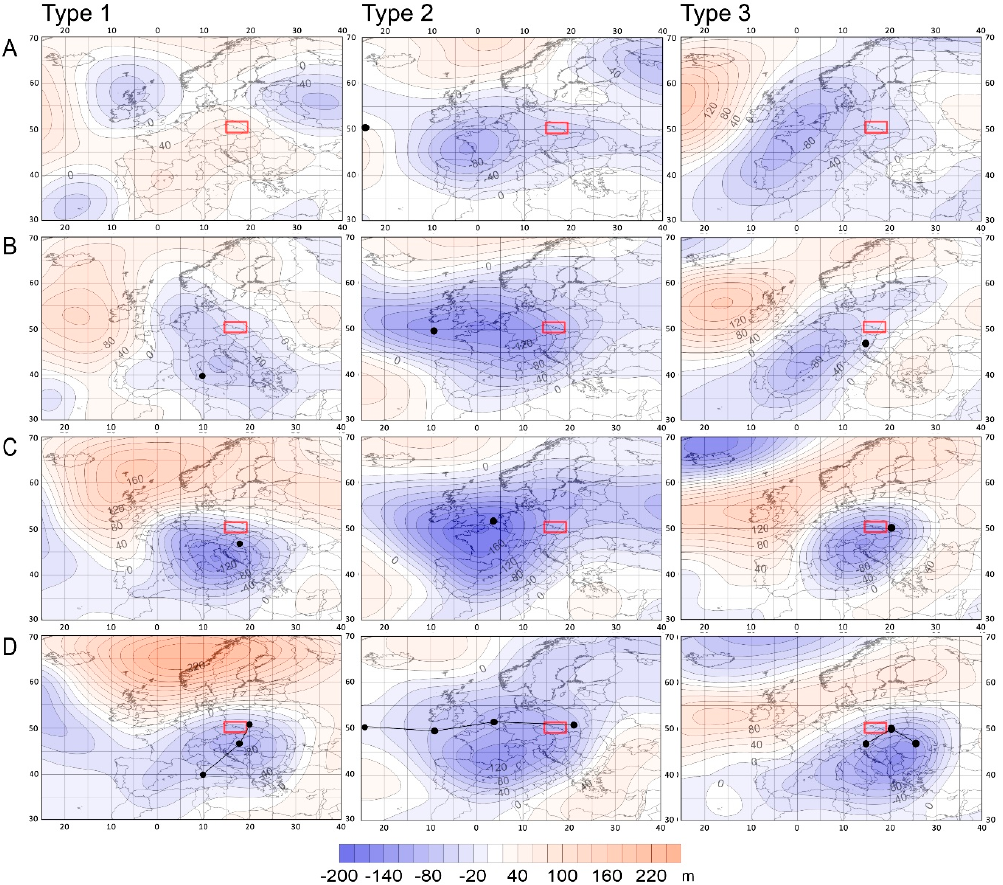
Figure 7. Circulation types 1, 2, 3 mean Z500 anomalies (m) 6 days ( A ), 4 days ( B ), and 2 days ( C ) before the flood culmination and on the flood culmination day ( D ); black dots indicate centers of negative SLP anomalies (repeated from Figure 5) and in column D cyclone tracks are marked; region of Polish Sudeten Mountains marked as red rectangle.